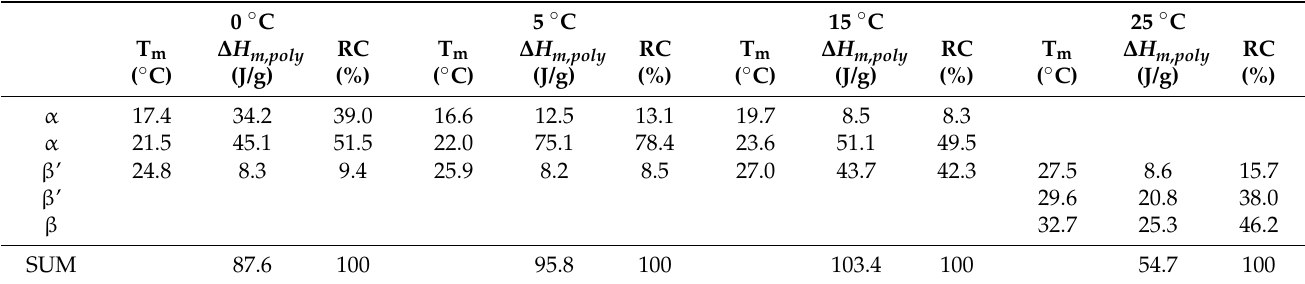
Table 7. Melting temperature and enthalpy of different polymorphs, as well as relative contribution (RC) of the total melting enthalpy, obtained by deconvolution of the DSC results of non-tempered cocoa